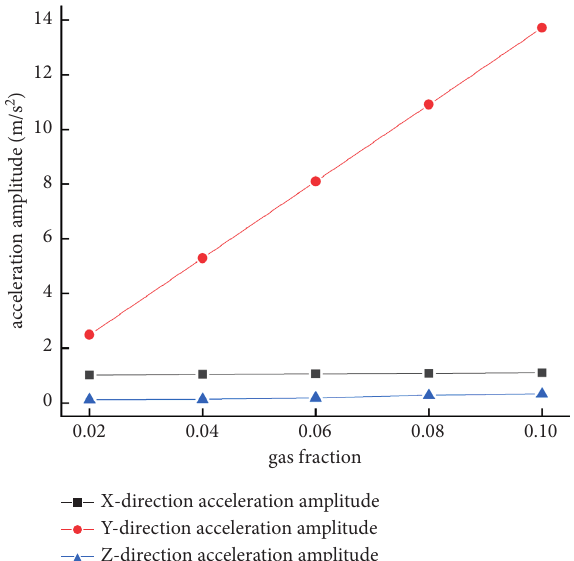
Figure 15: Variation curve of acceleration amplitude in different directions with natural gas fraction.